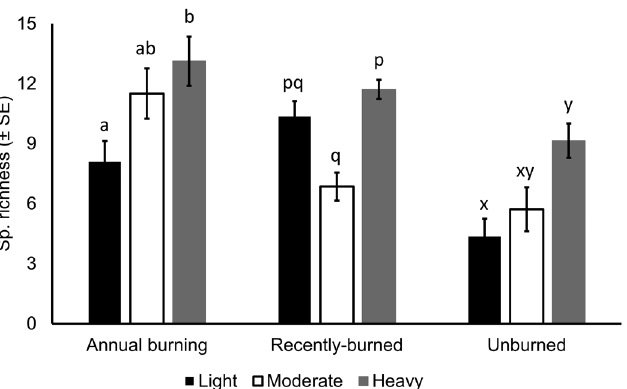
Fig. 2. Grasshopper species richness responds to grazing intensity under different fire regimes. Pairwise comparisons among grazing intensity classes (light, moderate and heavy) for annually-burned firebreaks and grasslands with longer fire rotations that were re- cently-burned i.e. <12 months prior to sampling and unburned i.e. burned >12 months prior to sampling. Bars with the same let- ters are not significantly different from one another.